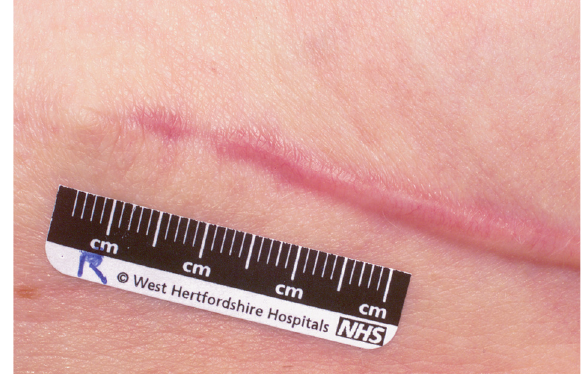
Figure 4: A hypertrophic postsurgical scar. Figure 5: Presternal keloid